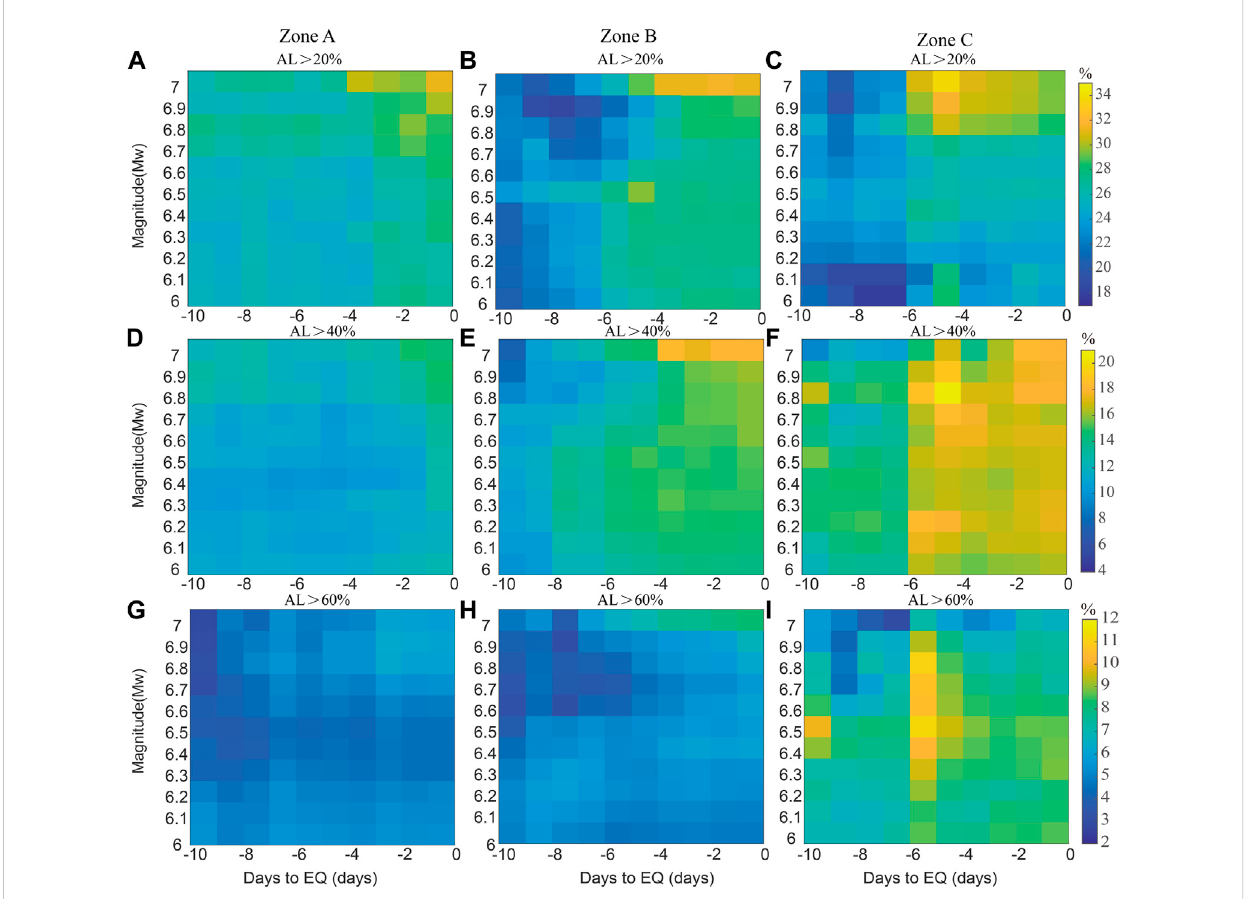
FIGURE 7 Seismo-ionosphericanomaliesoccurrenceratesofAL > 20%,40%,and60%within1-10daysbeforeearthquakesofZoneA (A,D,G) ,ZoneB (B,E,H) , and Zone C (C, F, I) , respectively (15-day sliding